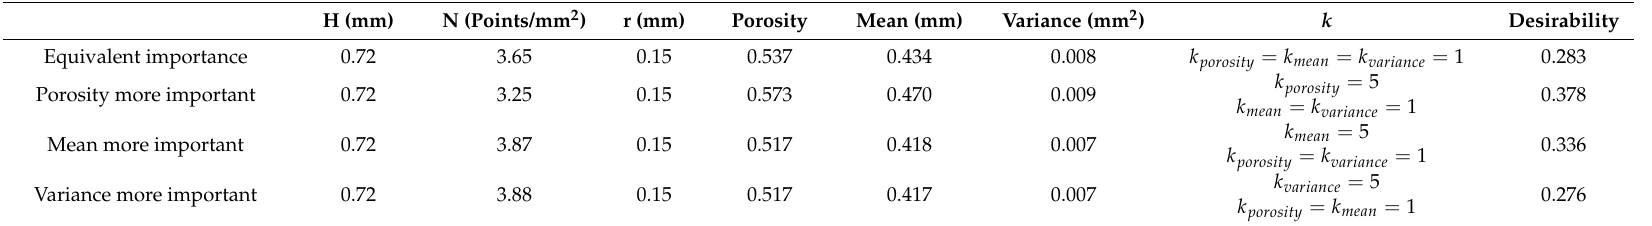
Table 5. Optimization